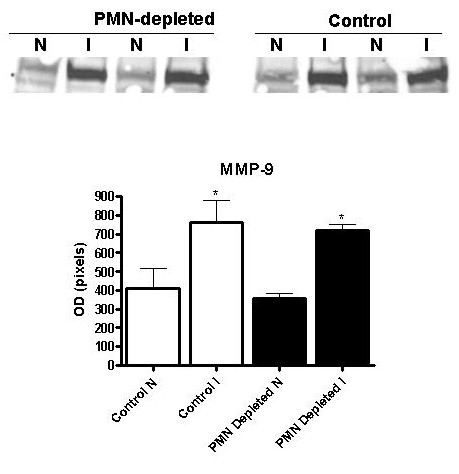
MMP-9 protein expression is unchanged by neutrophil depletion. (A). Representative immunoblot showing immunoreactive MMP-9 bands in both ischemic (I) and non-ischemic (N) hemispheres. (B) Densitometric analysis indicates an ischemia induced elevation of MMP-9 expression that is unaffected by PMN depletion. (*p < 0.05 vs contralateral hemisphere, control n = 6, PMN n = 4).